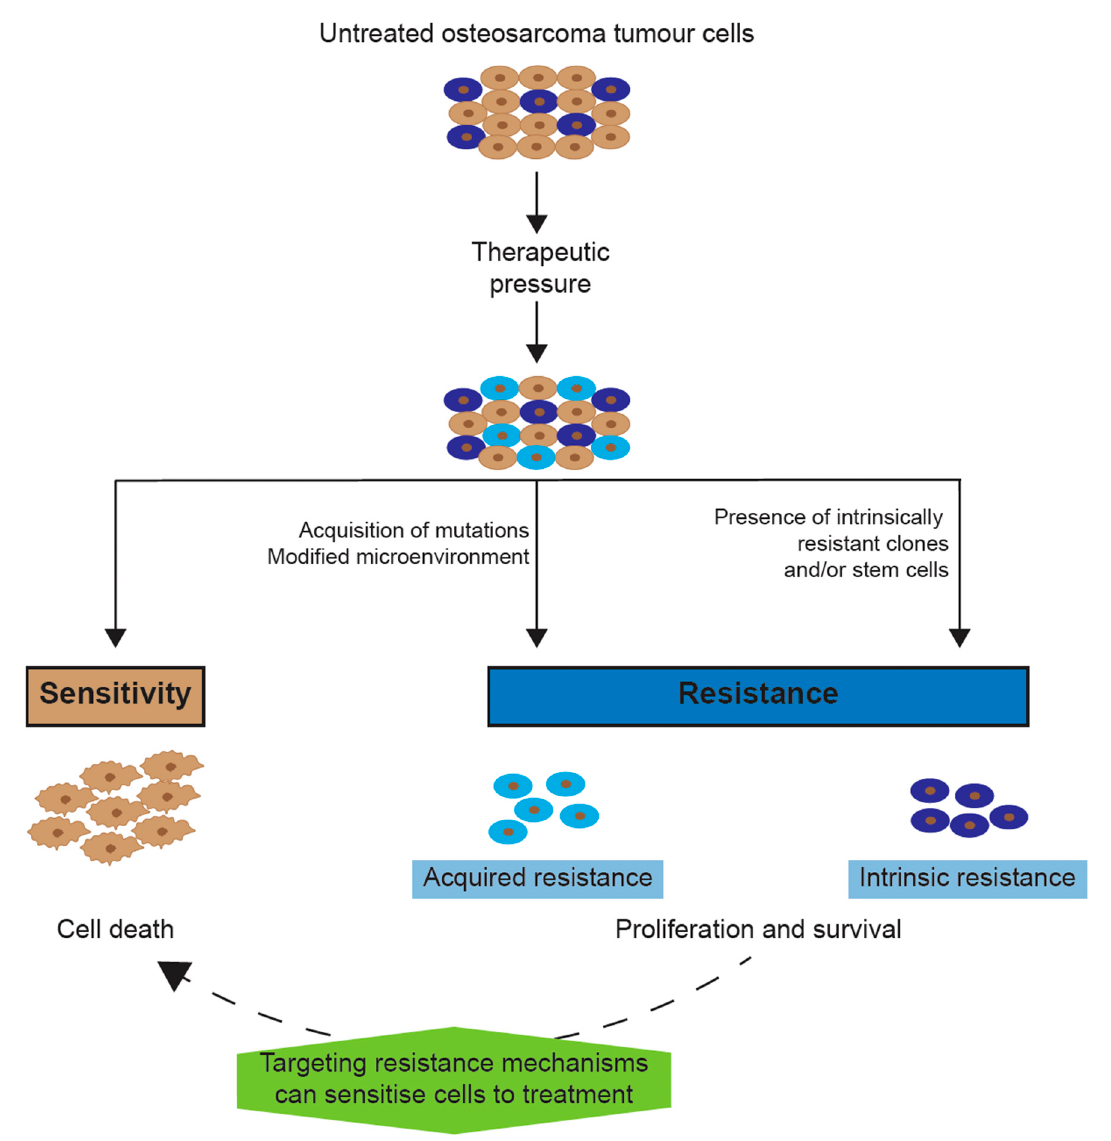
Figure 1. Model for chemotherapy resistance in osteosarcoma. The untreated population of tumour cells contains cells that are either sensitive (brown) to therapy or intrinsically resistant (purple). Therapy eradicates the sensitive population, while the cells with intrinsic resistance are able to survive along with cells that acquire resistance due to therapeutic pressure. The resistant populations can become sensitive to chemotherapy by targeting mechanisms underlying their resistance.